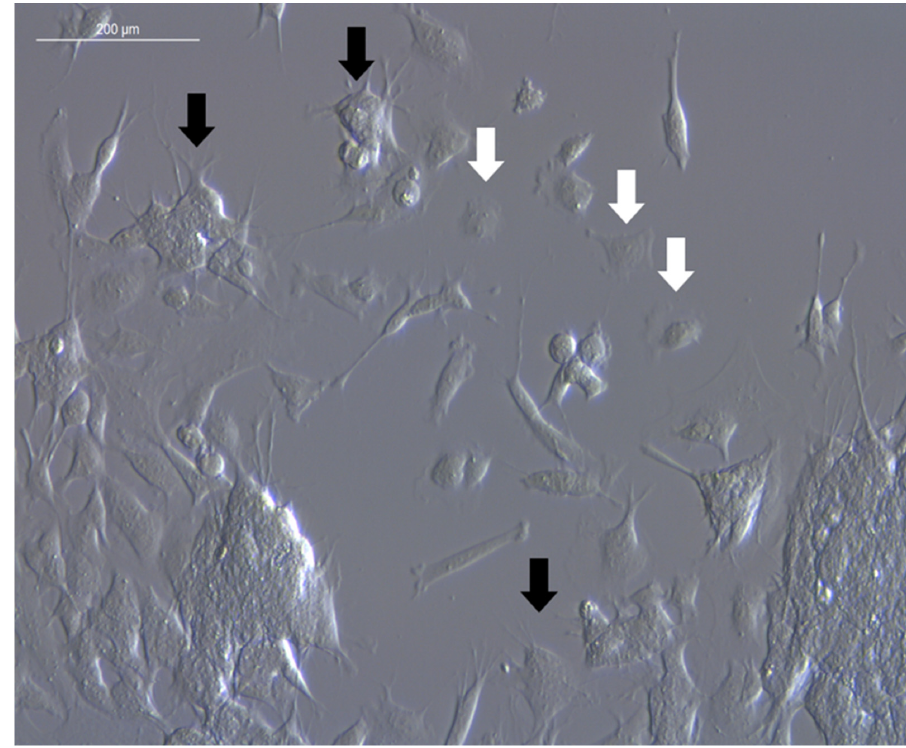
Figure 1. Morphology of SH-SY5Y cells after incubation of 96 h under standard culture conditions. The black arrows mark the neuron-like cells of the N-type; the white arrows point to the epithelial cell-like S-type. The N-type cells have distinctive unpolarized fine cell processes. 200 ×, IMC.